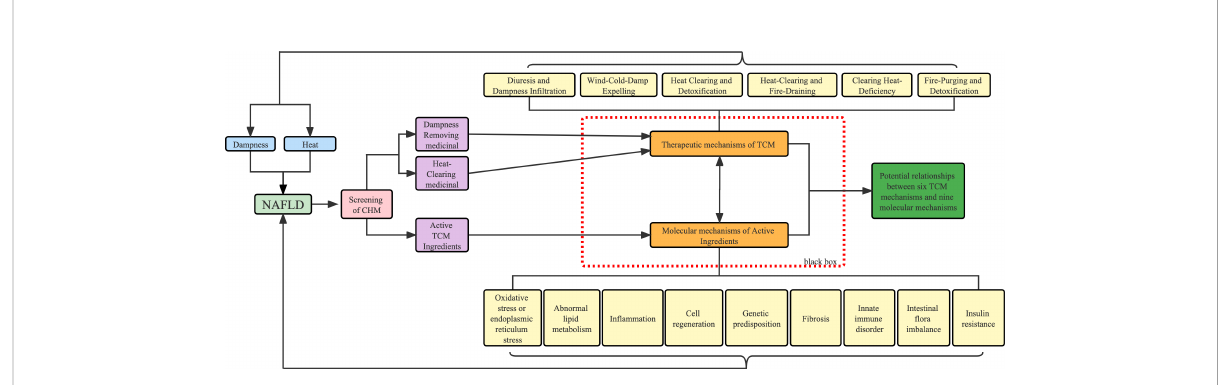
FIGURE 3 Work fl ow of this review. Blue represents the causative factors of NAFLD, purple represents the method of classi fi cation of drugs and light yellow represents the different pathological